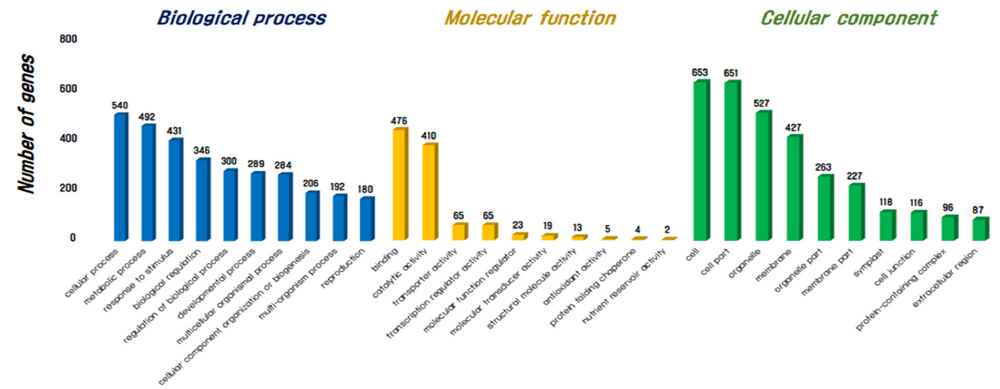
Figure 1. The number of genes in di ff erent gene ontology (GO)